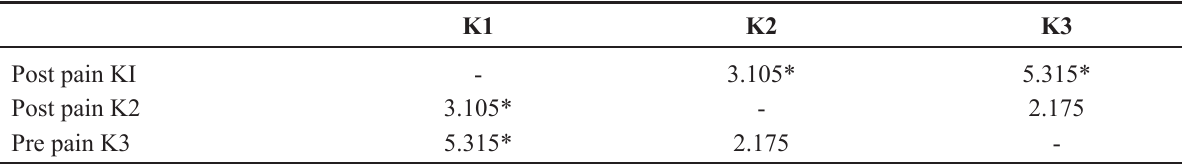
Table 3 – Post hock paired